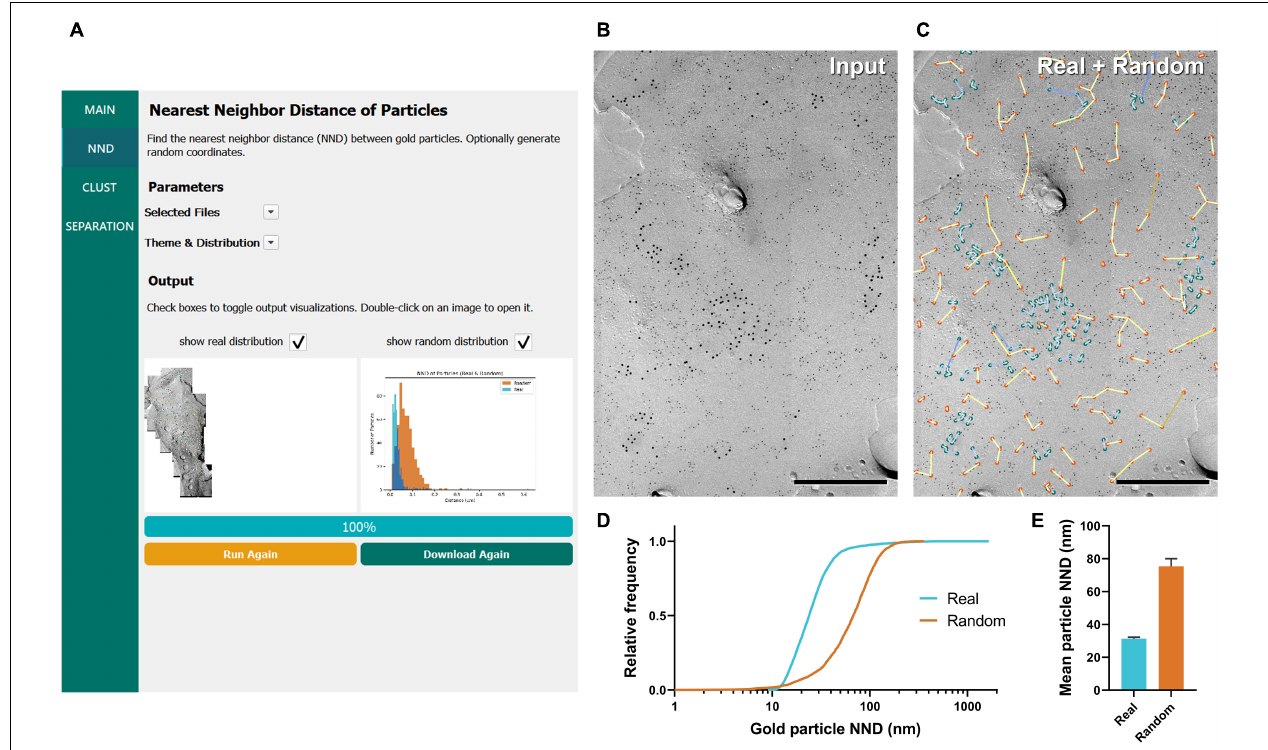
FIGURE 2 | GIO workflow result of gold particle NND analysis of Ca V 2.1 at the calyx of Held. (A) GIO interface showing the NND analysis workflow. Parameters such as the selected files and color theme can be changed here. The output for an ROI is displayed at the bottom of the interface; A labeled image of the ROI is displayed as well as a histogram of the particle NNDs for real and/or random distributions. Note that this is for one ROI only. (B) A portion of a calyx of Held ROI input image, with large 12 nm gold particles labeling Ca V 2.1. Small 6 nm gold particles were used as a cell-specific marker. (C) The GIO output of the same image in (B) , with real particles labeled in green and randomly distributed particles in orange (superimposed). Lines representing particle NND pairs are also drawn on the output. (D) Cumulative frequency distribution of real and random particle NNDs pooled across the six ROIs. (E) Grand mean particle NND comparing real and random particle distributions. Error bars represent S.E.M. n = 6 ROIs. Scale bars: 500